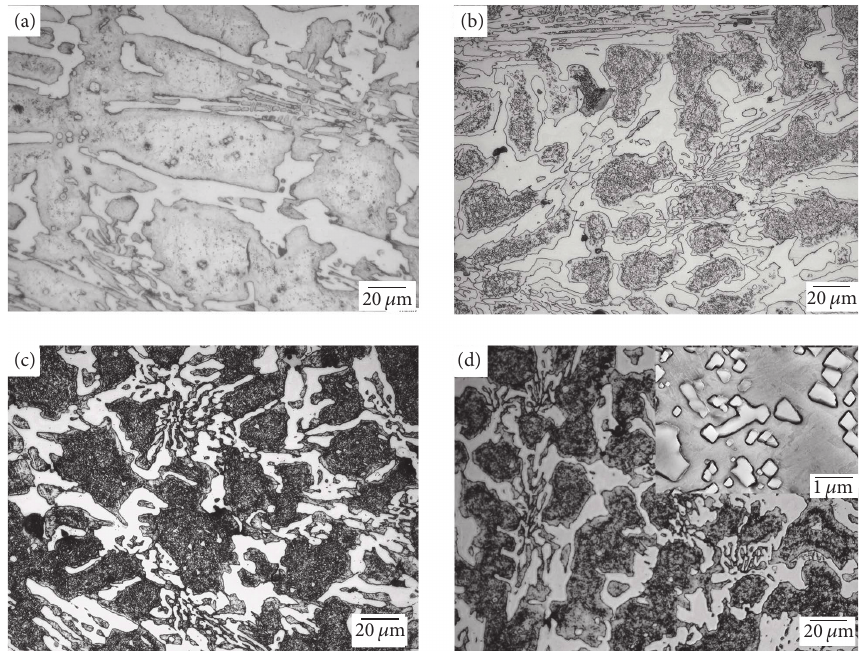
Figure 4: Microstructure of specimens: (a) as-cast, (b) quenching, (c) once tempering, and (d) twice tempering.